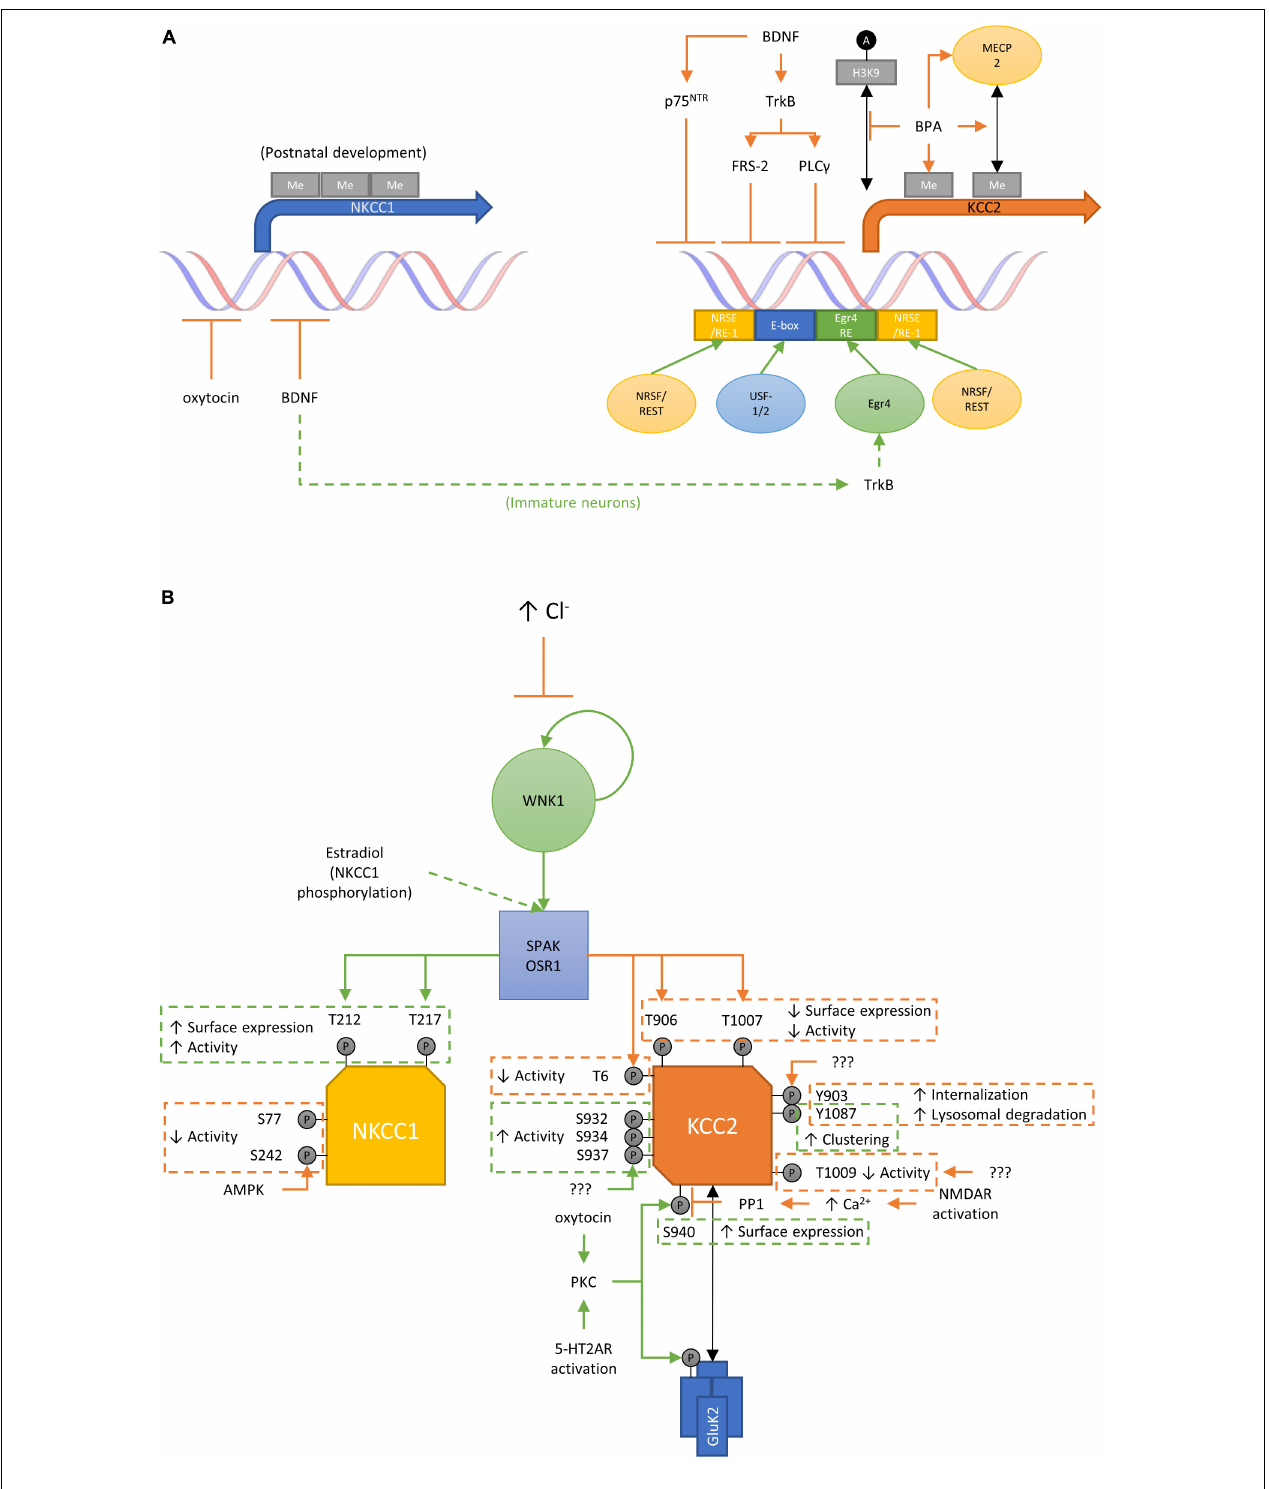
FIGURE 2 | (A) Transcriptional and epigenetic mechanisms involved in regulating KCC2 and NKCC1 expression. Transcriptional regulatory elements including NRSE/RE-1, E-box, and Erg4 RE are involved in regulating the expression of KCC2 and NKCC1 by various stimuli such as oxytocin and BDNF-TrkB/p75 NTR signaling. Additional regulatory mechanisms including DNA methylation and histone acetylation have also been demonstrated for KCC2 regulation. Given the association of chromatin regulators and other proteins that regulate gene expression with various neurodevelopmental disorders such as ASD, it will be of interest to determine how the expression of KCC2 and NKCC1, and ultimately the GABA-shift, may be affected in those pathologic conditions. A, acetylation; Me, DNA